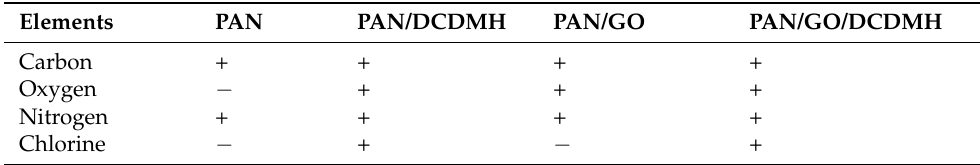
Table 2. Elemental information of PAN, PAN/DCDMH, PAN/GO, and PAN/GO/DCDMH detected by EDX spectra.